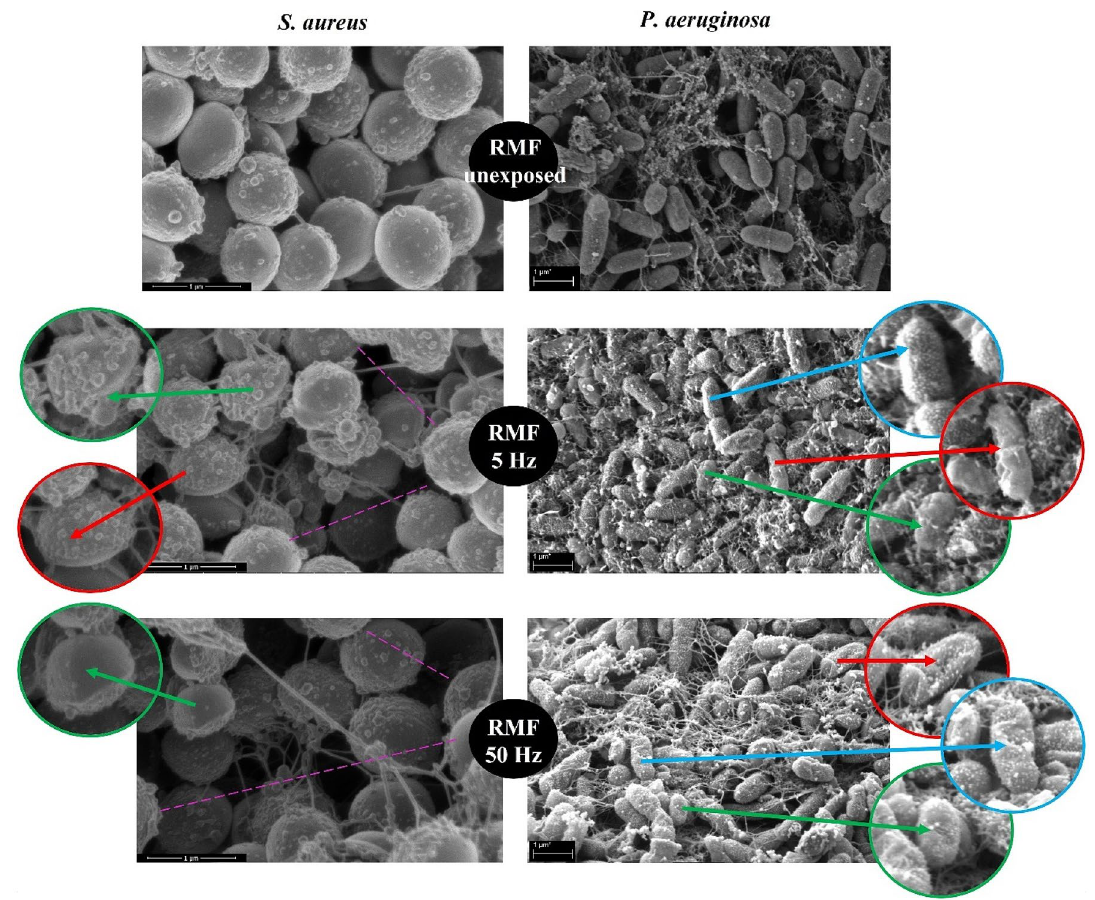
Figure 8. Morphology of ( a ) staphylococcal and ( b ) pseudomonal cells within biofilm structure exposed and unexposed to RMF. Green arrows indicate changes in cellular morphology; the red arrows indicate loss of turgor; blue arrows indicate granularities on the cell surface. The purple lines point out the increased distance between cells in biofilms exposed to the RMF. The magnification of staphylococcal biofilm equals 50,000× and pseudomonal biofilm